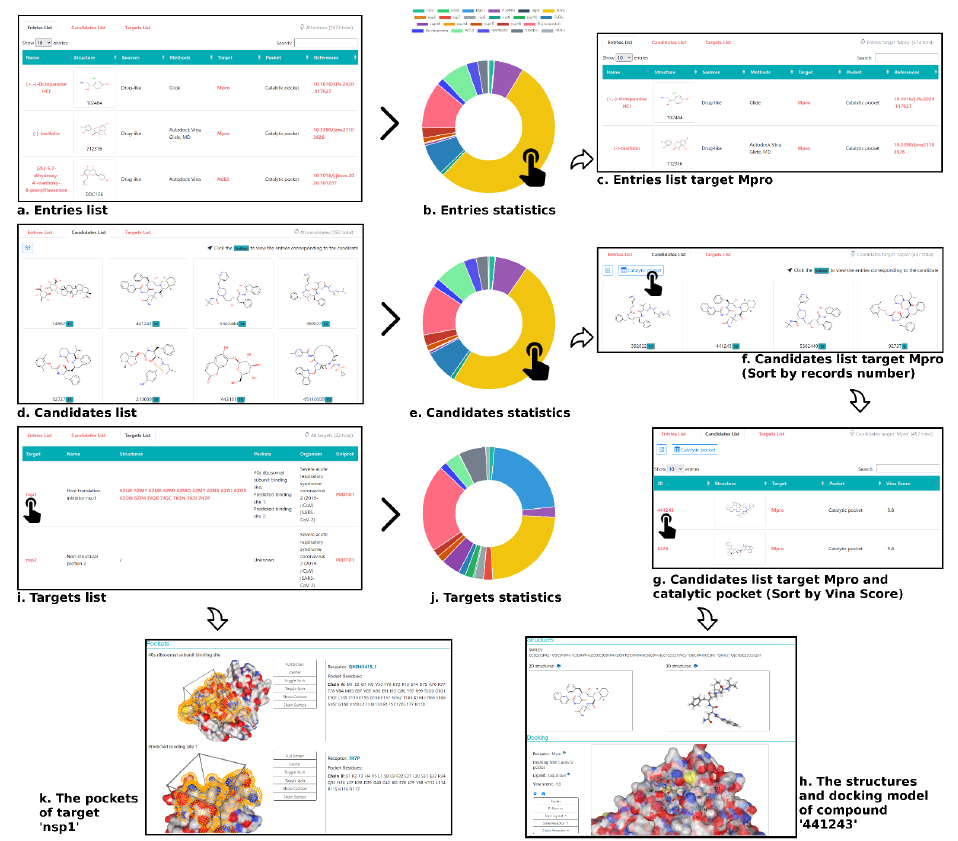
Figure 6. The web interface of DrugDevCovid19 server. ( a ) The ‘Entries List’ presented all the compound records retrieved from literature. ( b ) The donut chart displayed the statistics of compound records classified by the drug target. ( c ) The ‘Entries List’ presented compound records targeting Mpro. ( d) The ‘Candidates List’ presented all the non-redundant compounds contained in the records. ( e ) The donut chart displayed the statistics of non-redundant compounds classified by the drug target. ( f ) The ‘Candidates List’ presented the non-redundant compounds targeting Mpro (sorted by record number). ( g ) The ‘Candidates List’ presented the non-redundant compounds targeting catalytic pocket of Mpro (sorted by Vina score). ( h ) The structural information and docking conformation of compound 441243 (PubChem CID) targeting the catalytic pocket of Mpro. ( i ) The ‘Targets List’ presented all the potential drug targets. ( j ) The donut chart displayed the statistics of experimentally solved structures classified by the drug target. ( k ) The 3D structural features and surface residues of the active sites of nsp1.